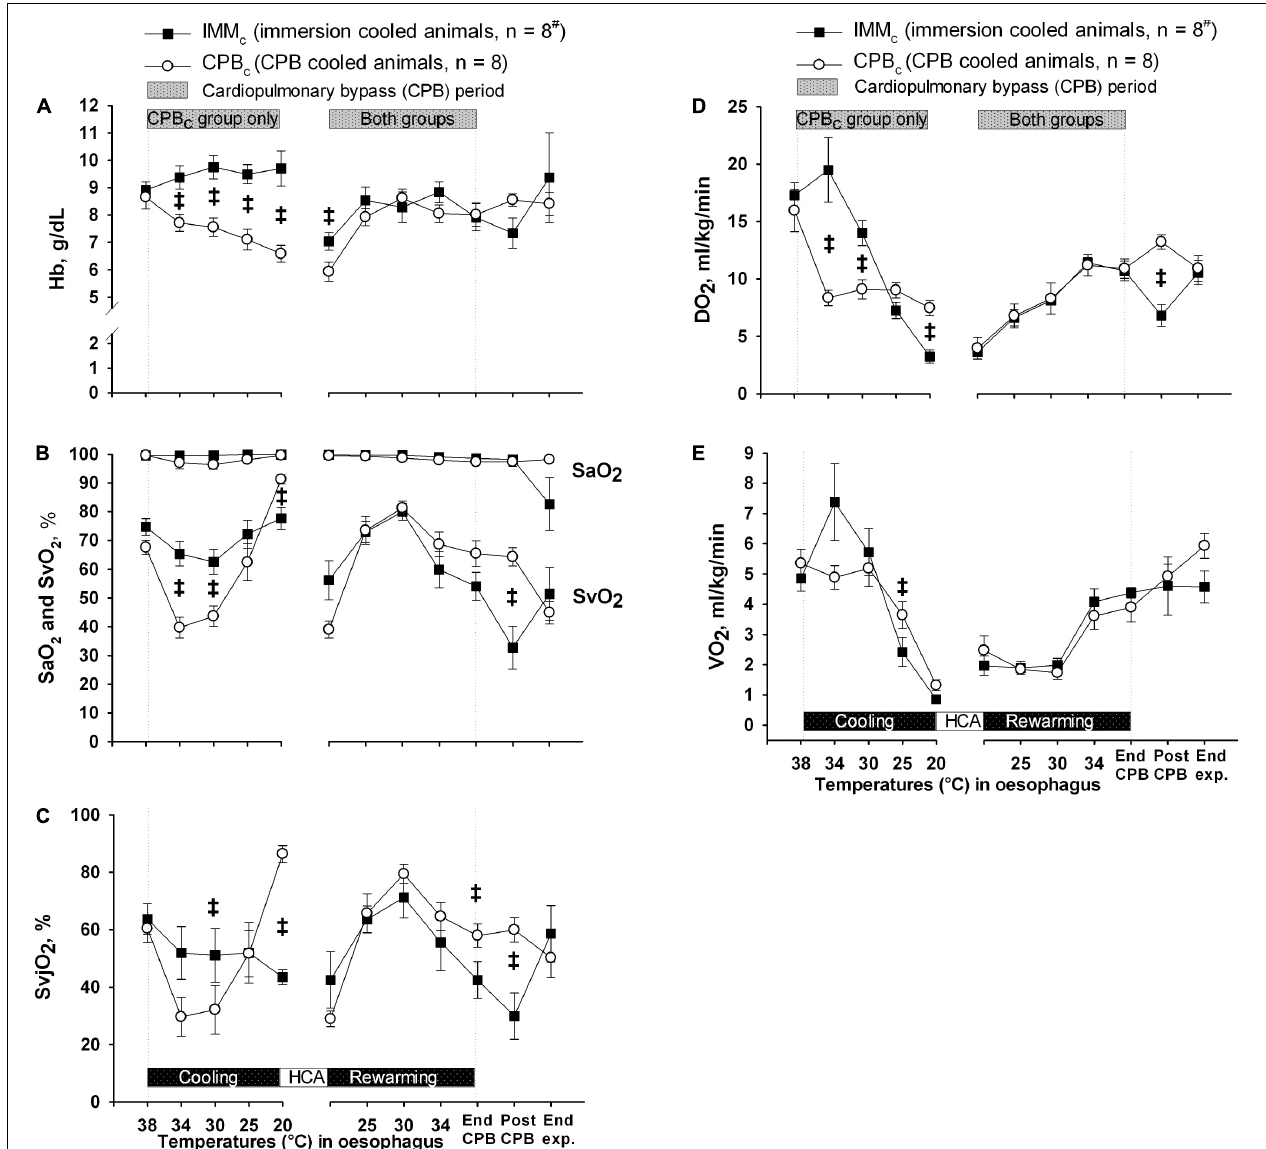
FIGURE 4 | Oxygen variables. (A) Blood hemoglobin (Hb) concentration. (B) Arterial and mixed venous blood oxygen saturation (SaO 2 and SVO 2 ). (C) Internal jugular venous blood oxygen saturation (SvjO 2 ). (D) Global delivery of oxygen (DO 2 ). (E) Global consumption of oxygen (VO 2 ). Data presented as mean and SEM. ‡ Statistically significant difference between groups ( p < 0.05). # n was reduced to 5 animals after termination of CPB (Post CPB) and to 4 animals at end of experiments (End exp.) in IMM c